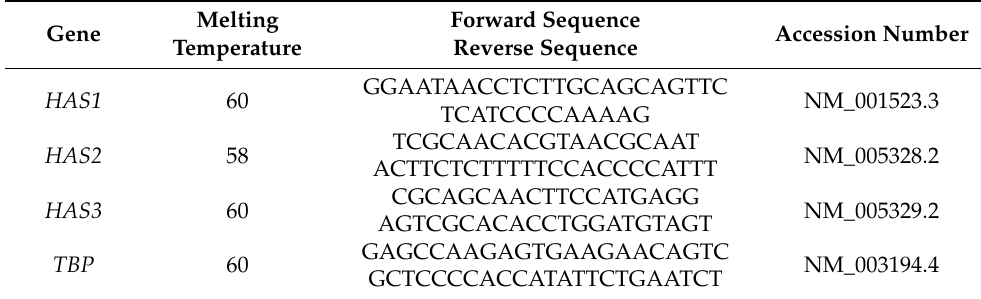
Table 1. Primers used for quantitative real-time